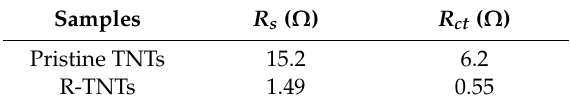
Figure S1: Current-voltage graph for cathodic reduction process; Figure S2: Current-time graph for cathodic reduction